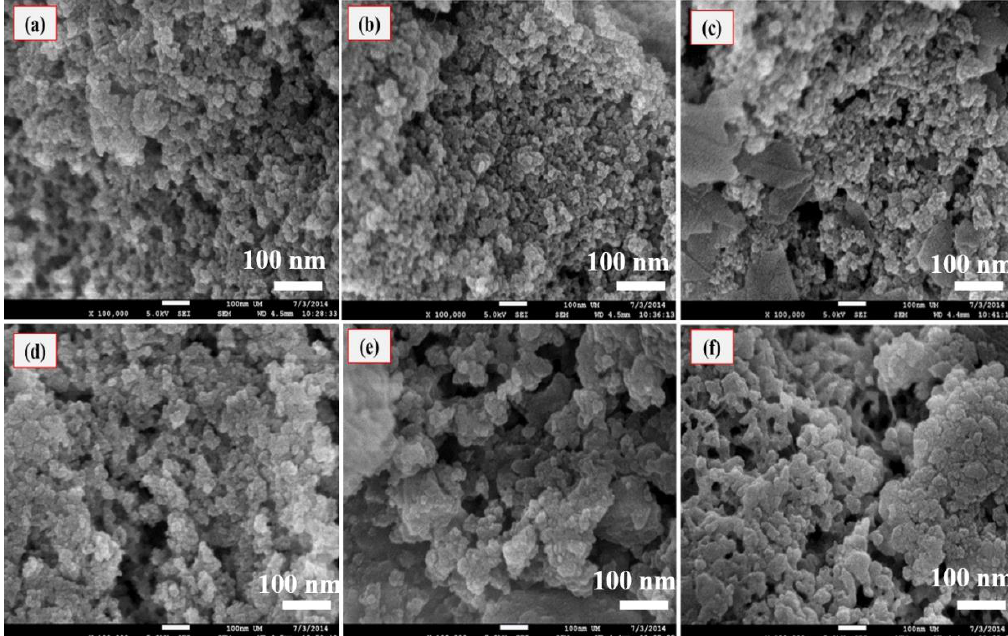
Figure 9. FESEM micrographs of PPVA-AlPO 4 nanocomposite samples formed from different pH of ( a ) 7; ( b ) 8; ( c ) 9; ( d ) 10; ( e ) 11, and ( f ) 12 at 100 k magnification.